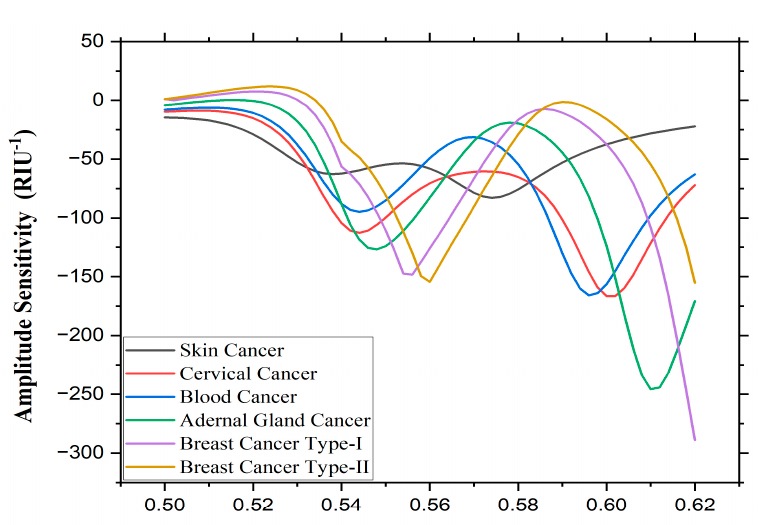
Figure 5. Confinement loss properties of the proposed PCF-SPR biosensor for different kinds of normal and malignant cells.